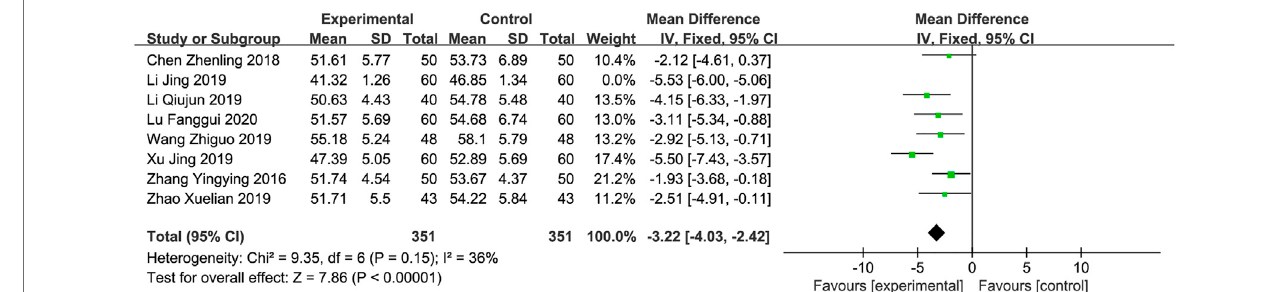
FIGURE 4 | Forest plot of LVEDD.